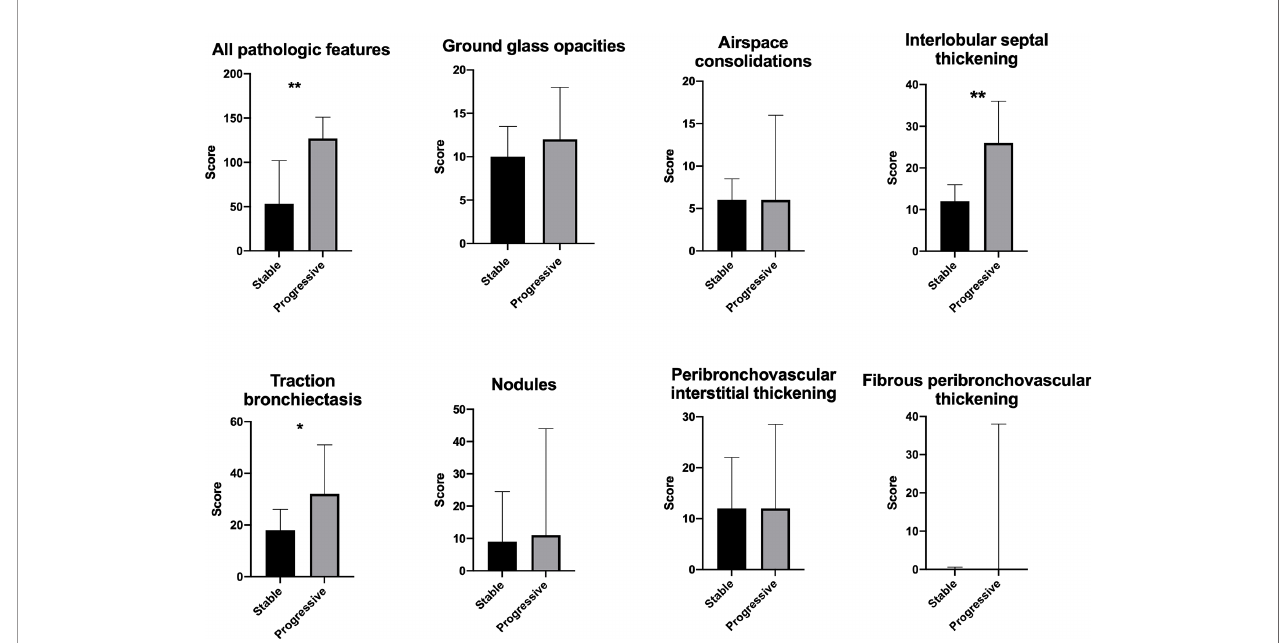
FIGURE 3 | Pulmonary CT scans of patients with stable and progressive disease with score of all pathological features combined and score of speci fi c features. Median and interquartile range. *p < 0.05. **p <